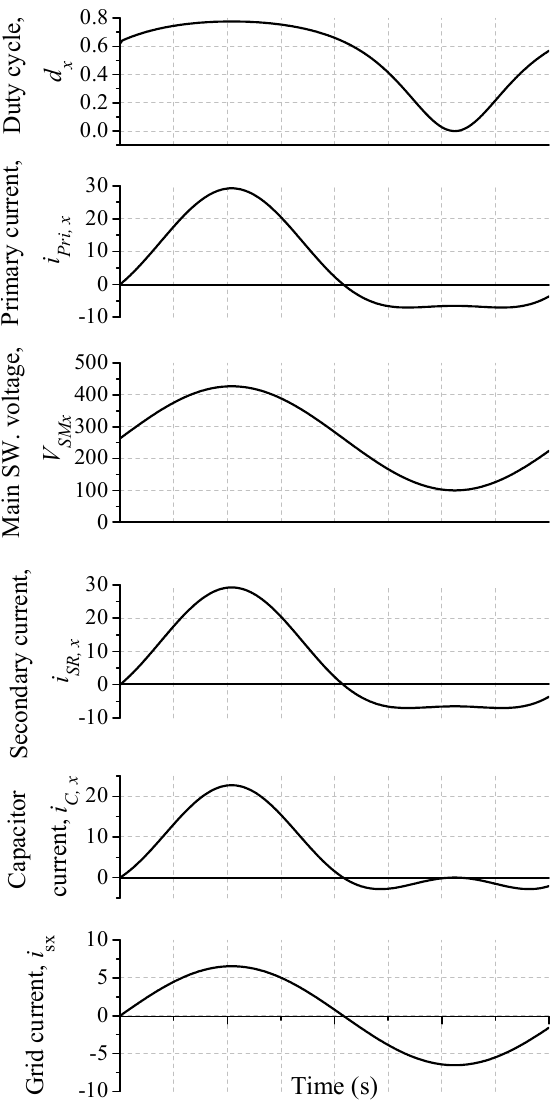
Figure 8. Averaged one-cycle of the proposed MFBDI.